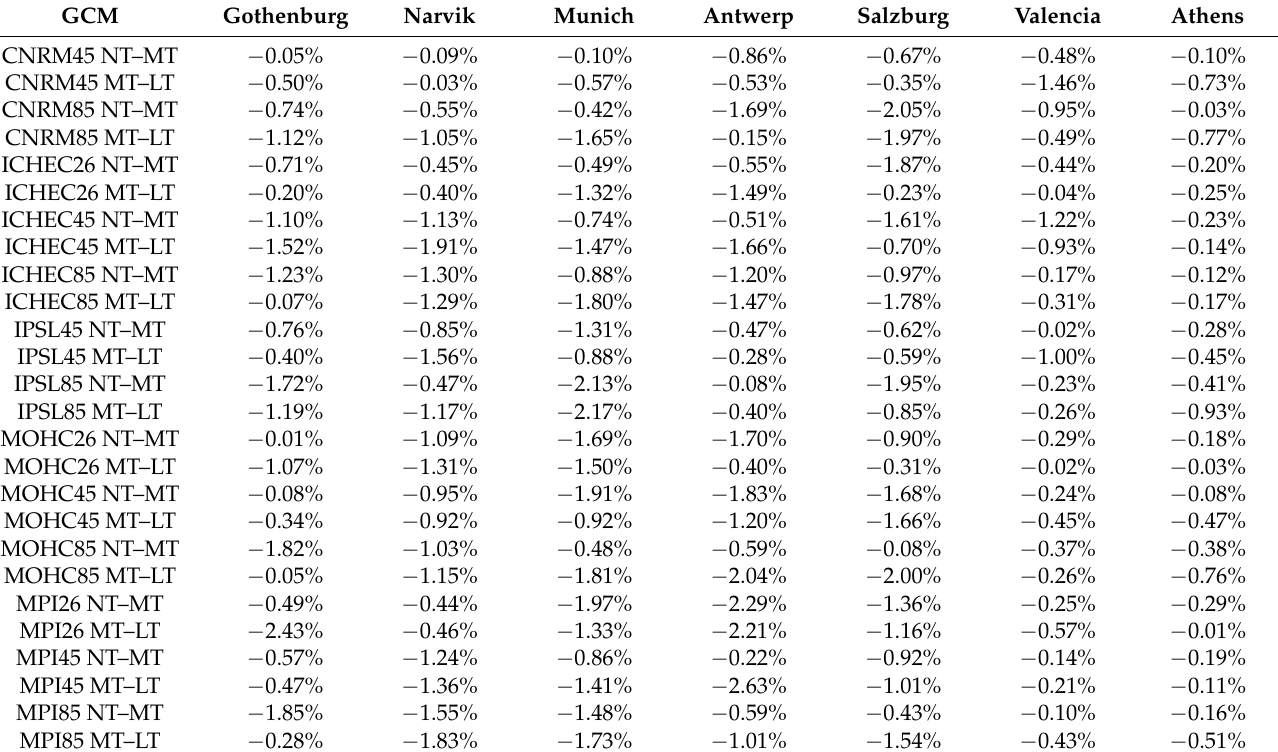
Table 2. Relative difference of NT–MT and MT–LT of PV output for each climate